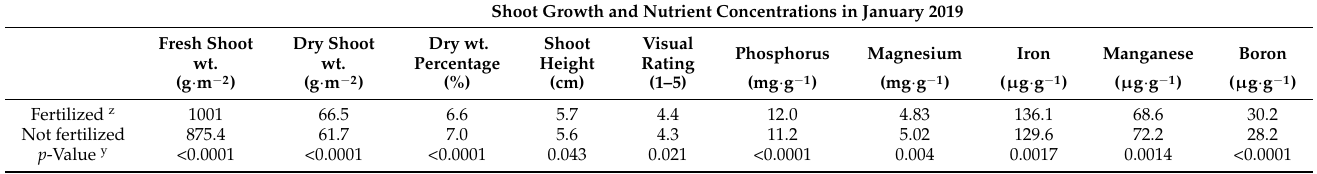
Table 3. Microgreen shoot growth and nutrient concentrations on a dry weight basis affected by fertilization in January 2019. Shoot Growth and Nutrient Concentrations in January 2019 Fresh Shoot Dry Shoot wt. wt.